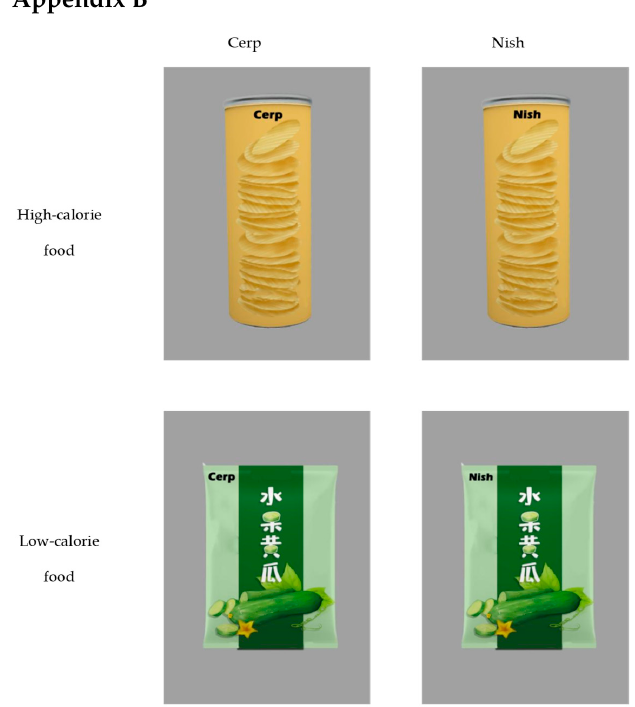
Figure A2. Examples of food pictures used in Study 2.